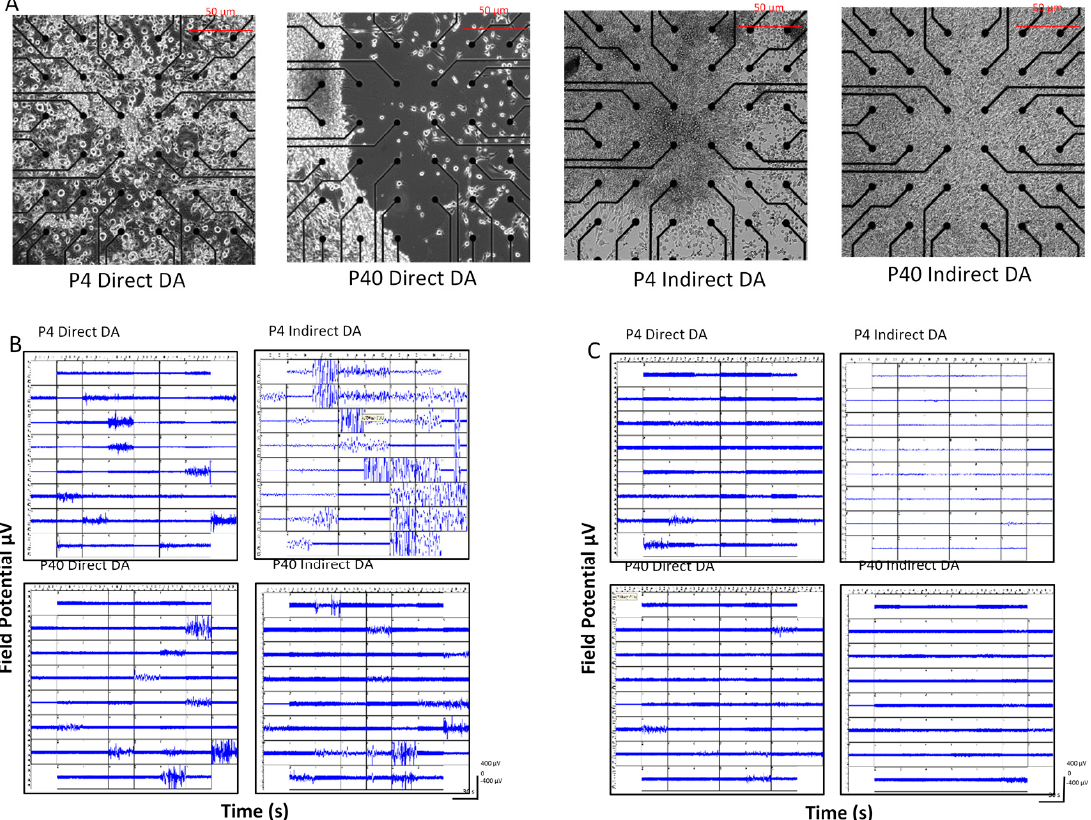
Figure 13. Multi-electrode recordings from early and later passaged MSCs following the DDI and IDI. ( A ) Images of P4 and P40 differentiated MSCs and surrounding electrodes (black dots). ( B ) Recordings of P4 and P40 MSCs following the DDI and IDI. At 2–3 weeks following differentiation, MSCs exhibit spontaneous neuronal activity. ( C ) Neuronal activity is reduced in all groups following addition of TTX to the MEA well at a final concentration of 1 µM. Samples were recorded for 10 min (600 s). TTX was added to culture media at ~300 s.